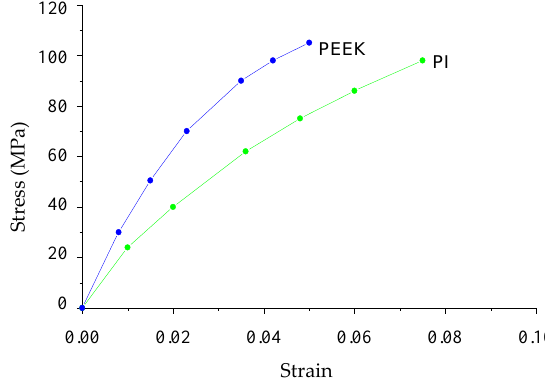
Figure 12. The stress–strain diagrams for PEEK and PI.